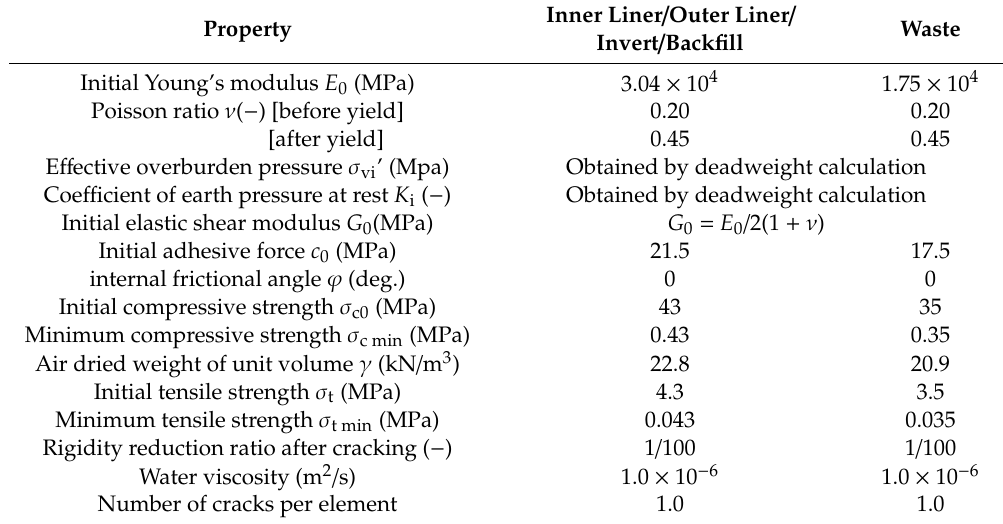
Table A4. Properties for cement